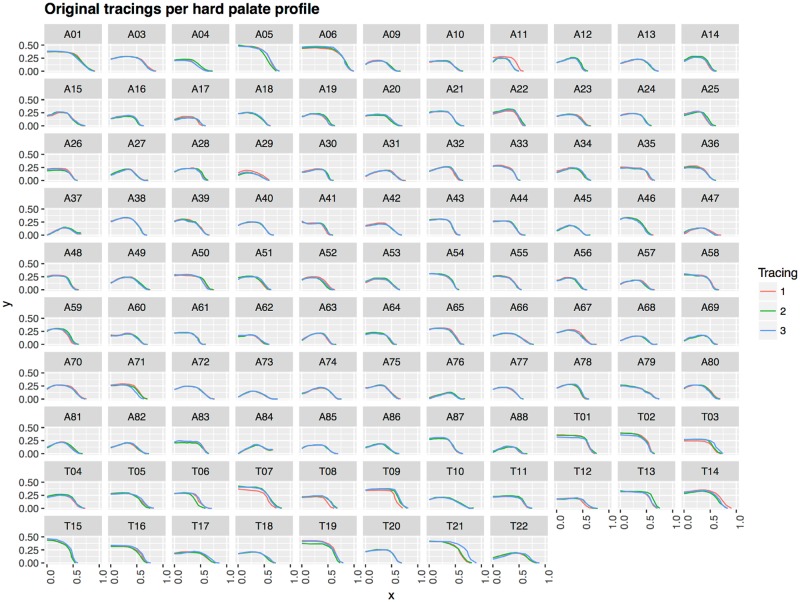
Original tracings per hard palate profile.The three independent original replication tracings per HPP are shown with different colors. The tracings are oriented with the alveolar ridge to the right. The x and y coordinates have been mirrored to respect the conventions in this paper and are scaled respecting the original x/y scale. Fig 11 shows the normalized tracings allowing a better view of how the shape varies across the traces.